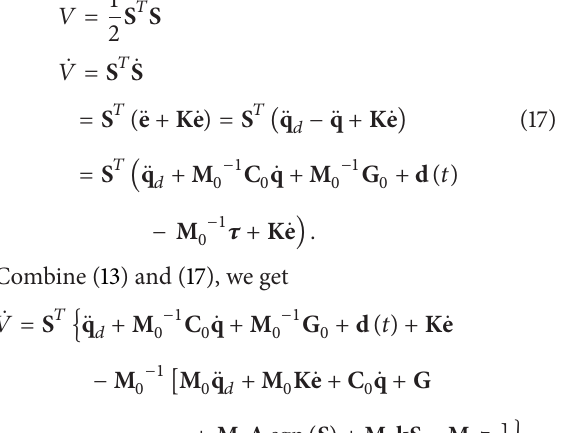
errors converge to zero. Considering the Lyapunov